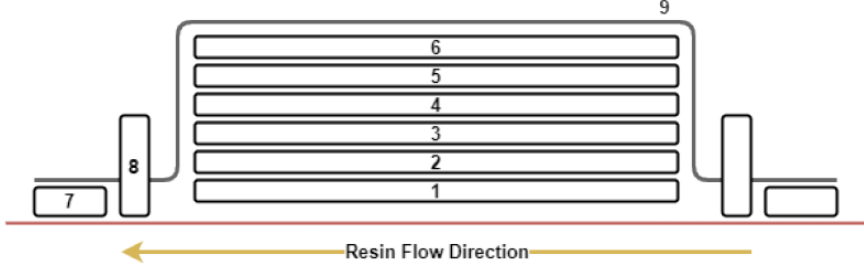
Figure 1. Schematic illustration of the vacuum-assisted resin transfer molding (VARTM)